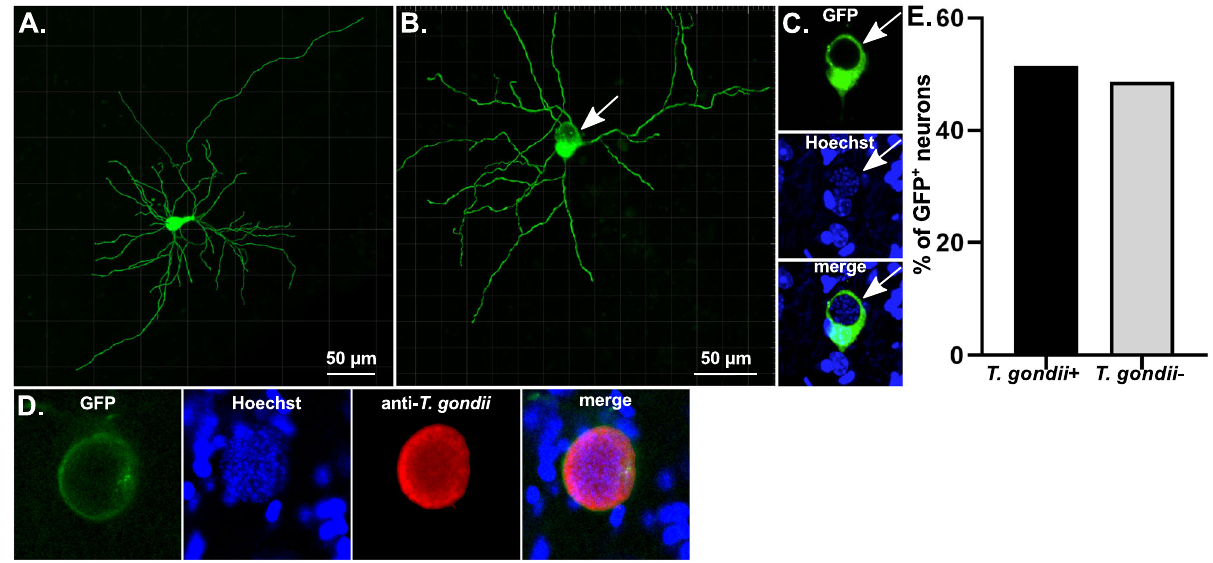
Fig. 5 | Fifty percent of GFP + neurons in mice infected with GCre parasites do notharborparasites. CrereportermicewereinfectedwithII-GCreparasites.At21 dpi, brains were harvested and sagittally sectioned into 200 µ m thick sections. Sectionswerecleared,stainedwithHoechst±anti- T.gondii antibodies,andimaged at40×onaconfocalmicroscope.Neuronsinresultingimageswererenderedusing Imarissoftware. A RepresentativerenderingofaGFP + neuroninwhichnoparasites were identi fi ed. B As in A except now with a GFP + neuron in which parasites were identi fi ed.Whitearrowshowsparasiteswithinneuronsoma. C Singleplaneofsoma from B topimage :green=GFP, middleimage :blue=Hoechst, bottomimage :merge.